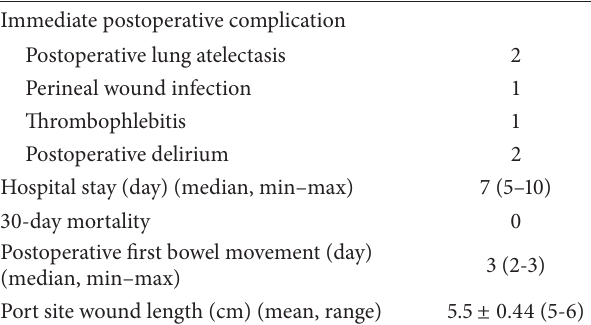
Table 3: Postoperative details and complications.